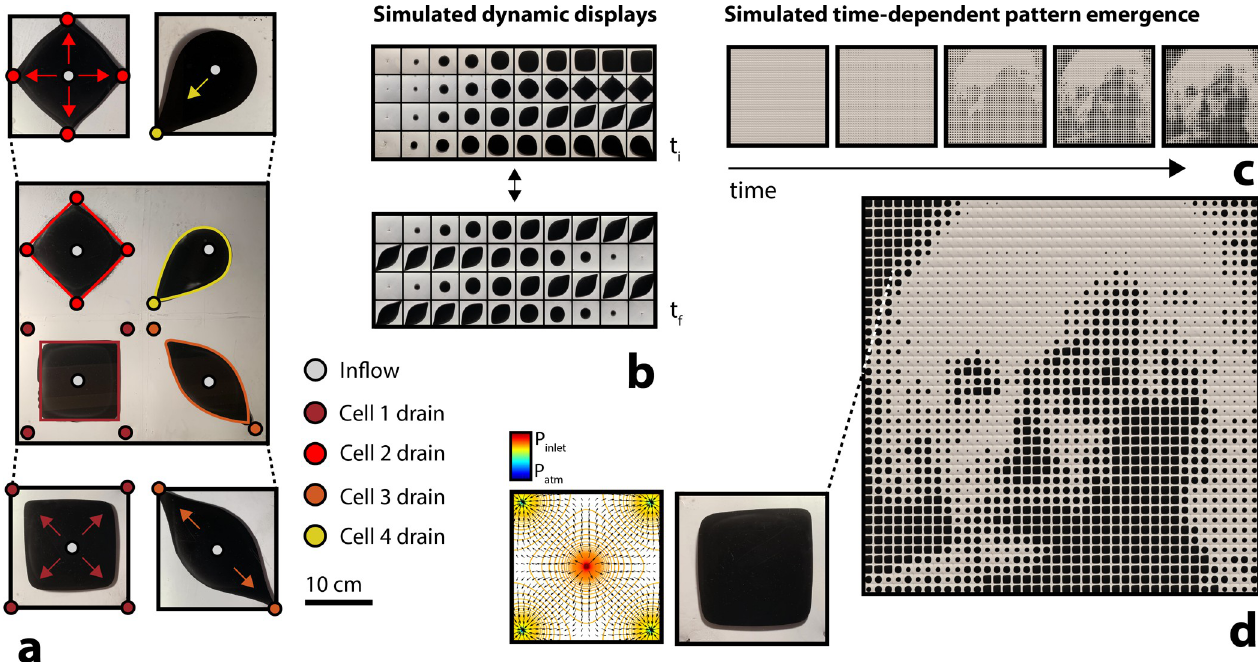
Fig 8. Fabricated and simulated multipixel visual displays. (a) Image of a built quad-cell display, where each array element demonstrates a unique flow field and pigment droplet morphology (t = 100 s after injection). (b) Examples of switchable digitally-generated multicell displays (unbuilt). (c) Simulated pattern emergence to achieve a predefined multicell visual array (d). Static flow field displayed next to corresponding pigment cell. Assuming a cell length of 20 cm, the visualized 40x40 cell display could stretch 8x8 m 2 .